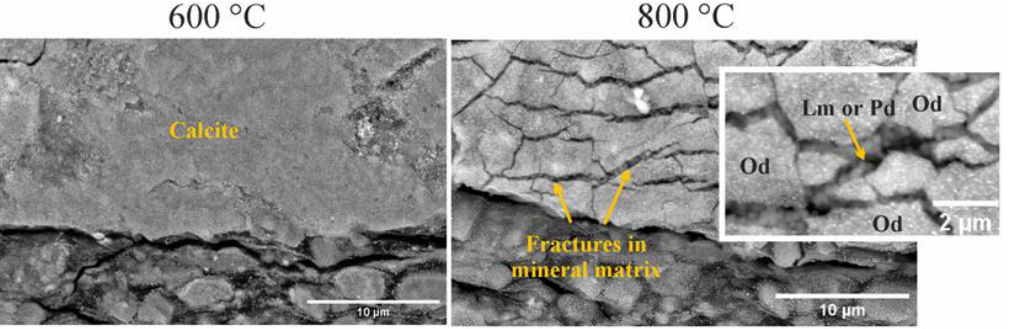
Figure 6. BIB-SEM images of sample Ch-46t at T = 600 °C and 800 °C. Structural alterations in carbonate mineral matrix occurred at T = 800 °C. Od — oldhamite (CaS); Lm — lime (CaO); Pd — portlandite (Ca(OH) 2 ).